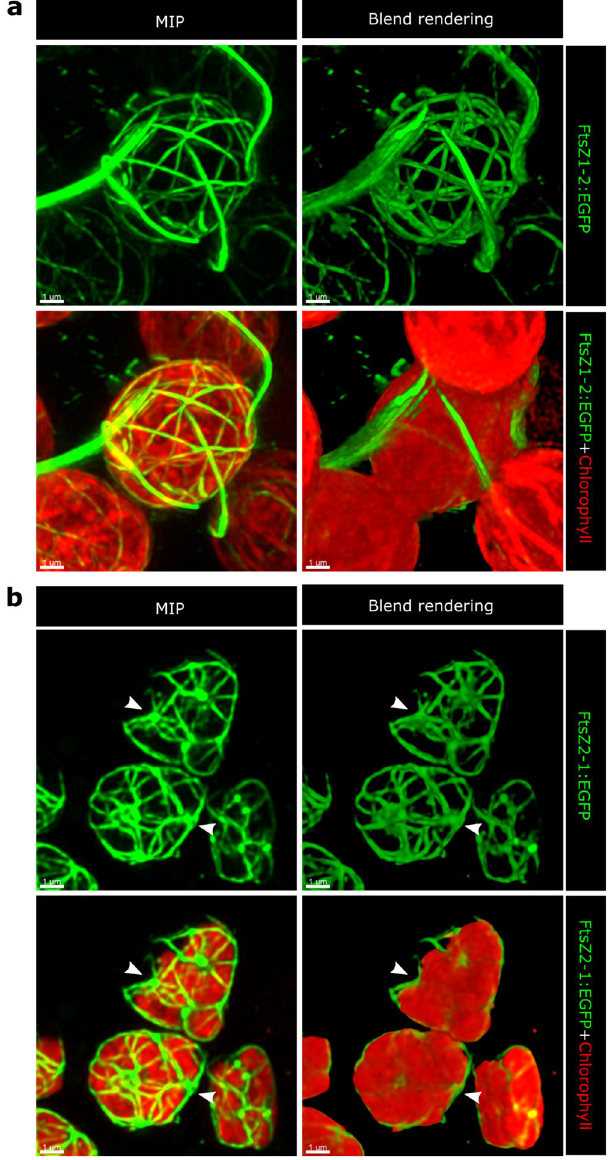
Figure 2. Examples of relatively simple networks and the corresponding chloroplasts hosting them are displayed. Confocal image z-stacks were deconvolved via Huygens software (Scientific Volume Imaging). For illustration, maximum intensity projection (MIP) and volume reconstruction (blend rendering) were applied to the deconvolved images via the IMARIS software (Bitplane). ( a ) FtsZ1-2 networks are characterised by extensive extraplastidic filaments. ( b ) FtsZ2-1 networks are interspersed with occasional meganodes (arrowheads). Visual analysis of the 3D images of the chloroplasts and FtsZ networks also reveals that the chloroplasts of the transfected cells often show morphological divergence from the standard chloroplast shape. This implies that elevated levels of FtsZ might induce morphological changes on the chloroplasts. Interestingly, the morphological deformation tends to have certain patterns which are